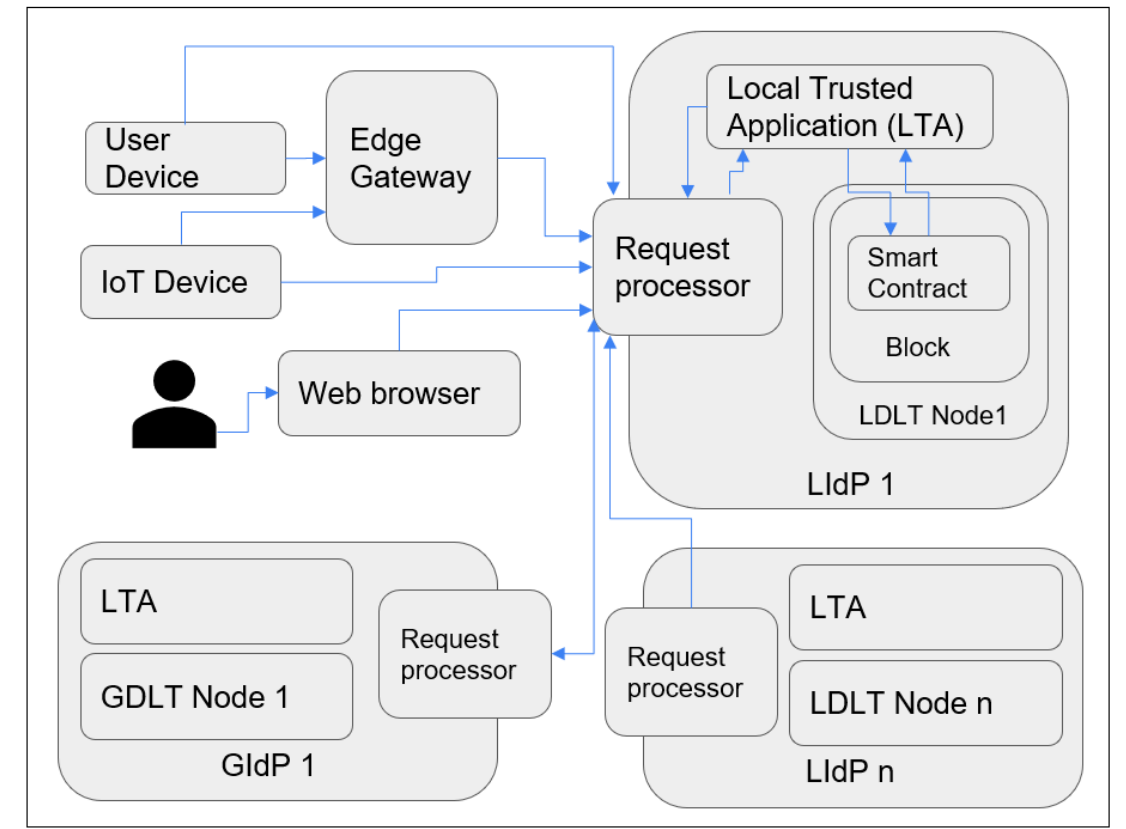
Figure 6. Overall workflow of the system.